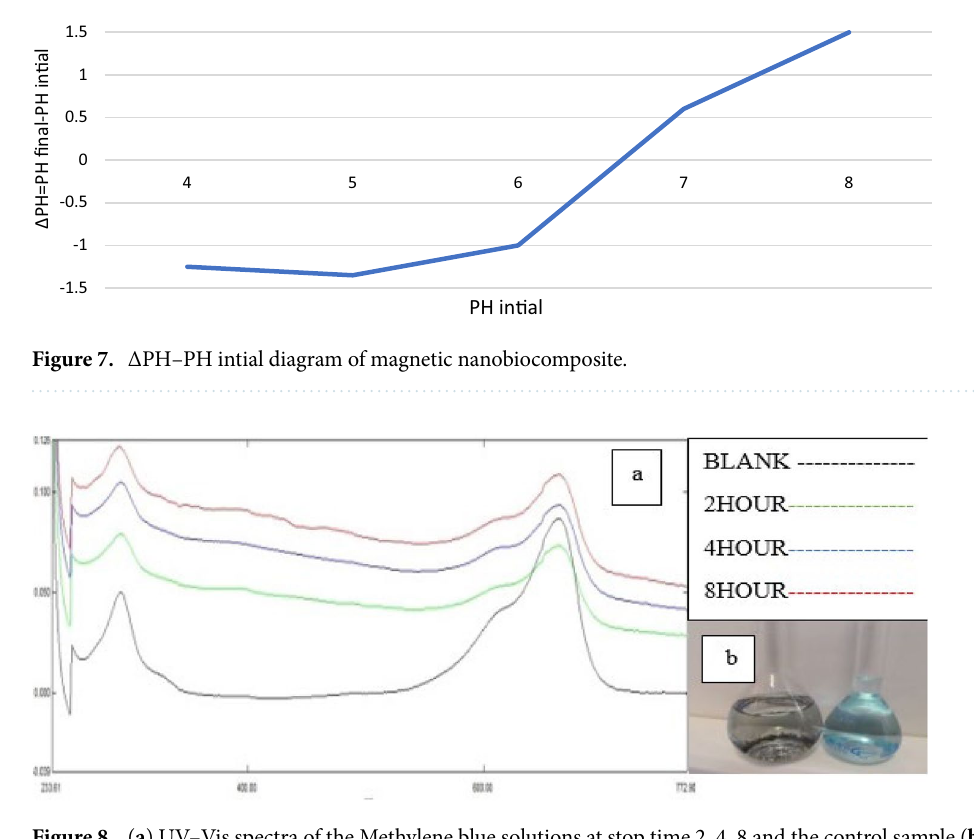
Figure 8. ( a ) UV–Vis spectra of the Methylene blue solutions at stop time 2, 4, 8 and the control sample ( b ) Comparison of the control sample and the absorbed sample after 8